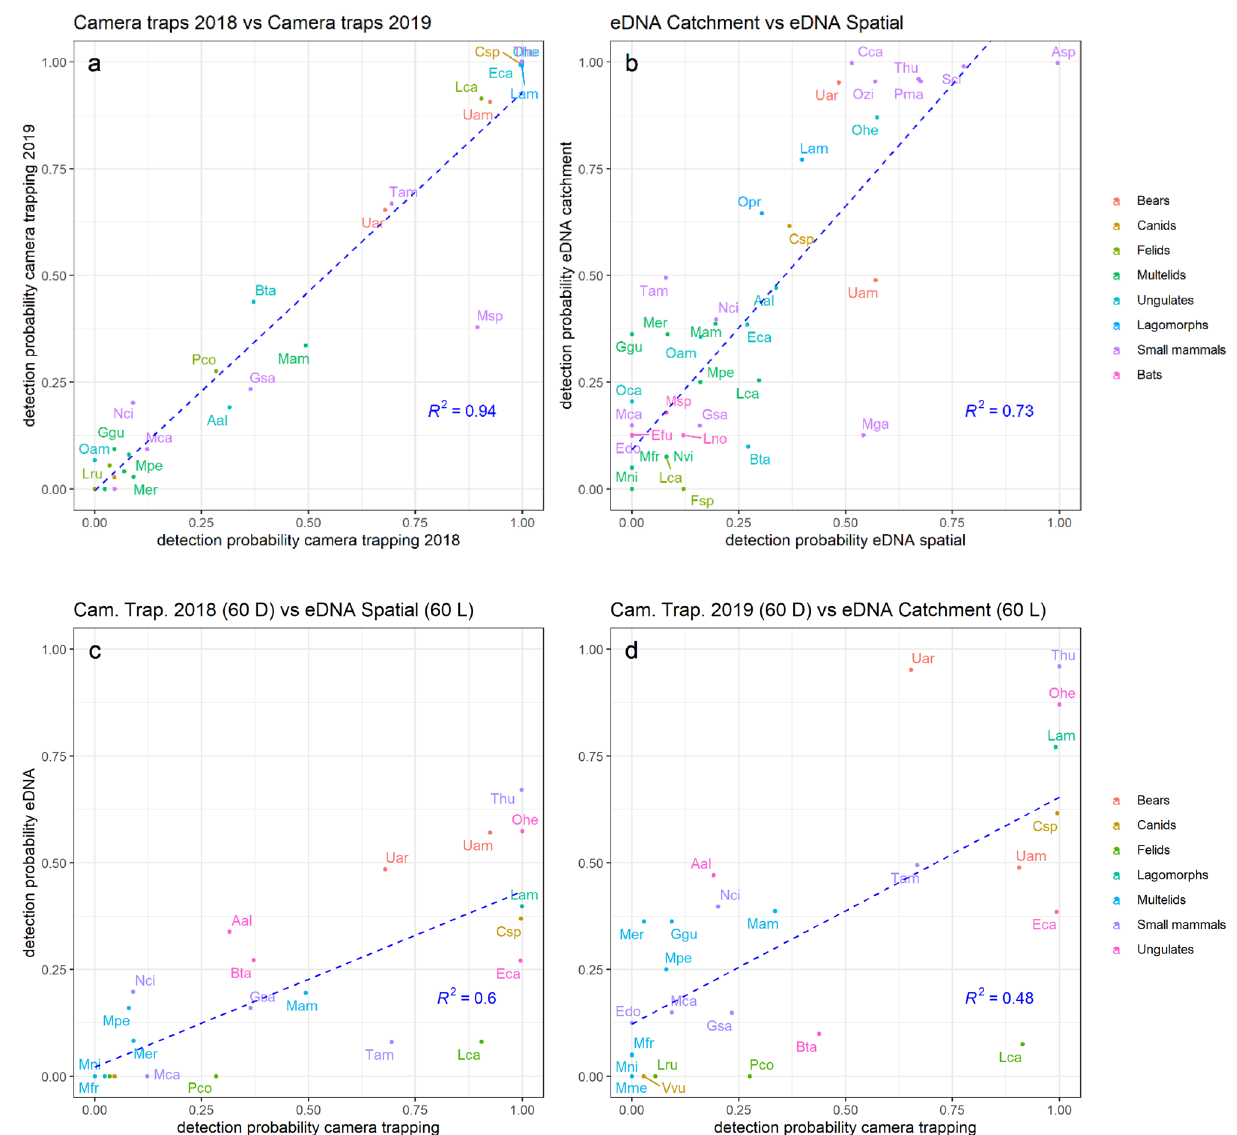
Figure 3. Species detection correlations between years and between methods. The top panels show the comparison of the average detection probabilities between 2018 and 2019 camera trapping surveys ( a ), and between catchment (y-axis) and spatial (x-axis) eDNA sampling strategies ( b ). Panel ( a ) includes only species targeted by the camera trap surveys, while panel ( b ) includes all species. The bottom panels ( c , d ) show the comparison of average detection probabilities between camera trapping (x-axis) and eDNA (y-axis), and includes only the species targeted by camera trap surveys: panel ( c ) shows camera trapping 2018 vs spatial eDNA, and panel ( d ) shows camera trapping 2019 vs catchment eDNA. Each individual species is represented by a dot and its associated label corresponds to the first letter of the genus followed by two first letters of the species name (e.g. “Uam” for Ursus americanus , or “Csp” for Canis spp). Full taxonomic names can be cross- referenced with the y-axis of Fig. 2. The dotted lines show the linear regression between the two variables. R 2 is the coefficient of correlation of the regression and is shown at the bottom right corner on each found a strong correlation between eDNA detection probability in the two independent sampling years of 2018 and 2019 (R 2 = 0.73; Fig. 3) suggesting a robust temporal signal of detection probabilities within eDNA samples. While eDNA samples for the spatial design and catchment design were collected from different years, the camera trap survey suggested the relative frequency of species present in the study area did not vary between the two years. First, camera detection rates per species were similar between 2018 and 2019 (R 2 = 0.94), suggesting a stable community of mammals in the study area (Fig. 3, Supplementary Figure 6). Additionally, for species targeted by camera traps, the detection probabilities recovered from both eDNA sampling strategies showed significant positive associations with the average camera trap detection probabilities estimated in 2018 and 2019 (R 2 = 0.61 in 2018, R 2 = 0.49 in 2019, Fig. 3, see “Methods” section).